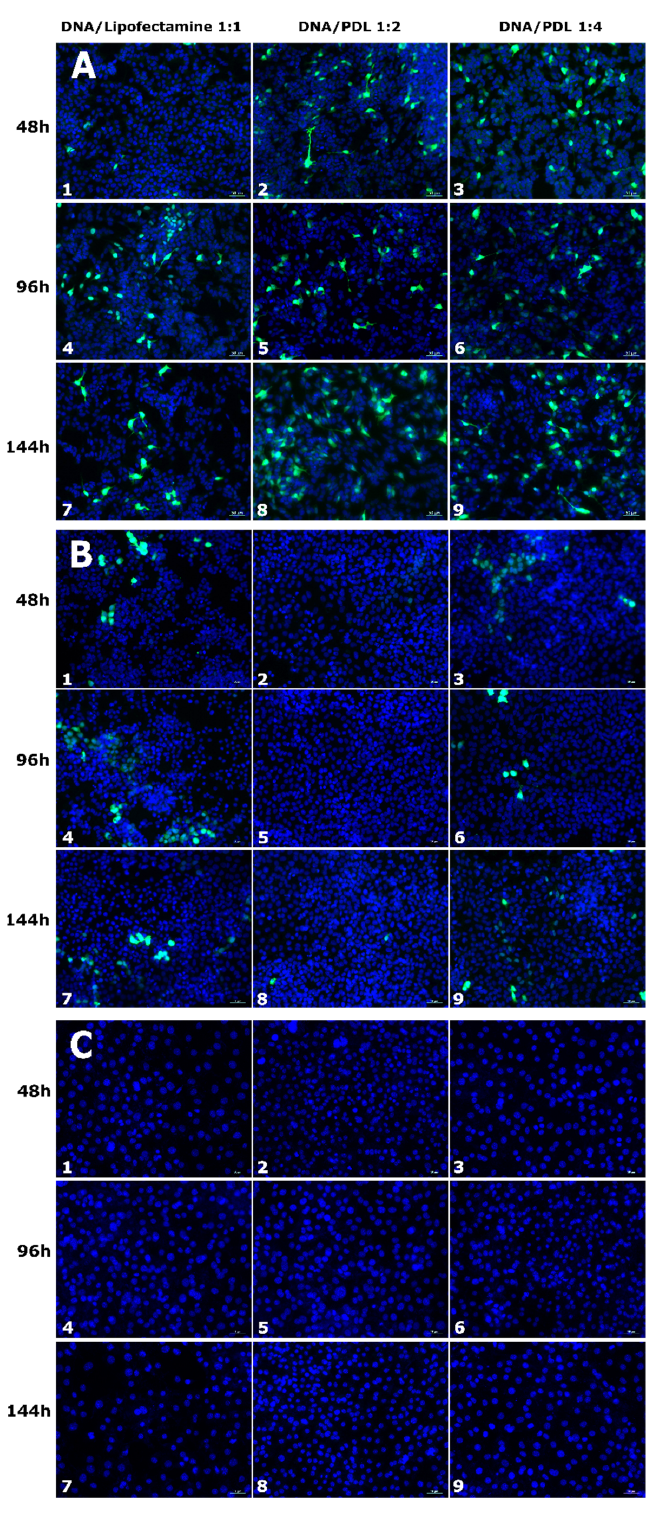
Figure 4. EGFP expression in SH-SY5Y ( A ), HeLa ( B ), and 3T3 ( C ) cells transfected with PDL or lipofectamine. EGFP expression (green) in cells treated with lipofectamine (1, 4, 7 columns), DNA/PDL (1:2) (2, 5, 8 columns) and DNA/PDL (1:4) (3, 6, 9 columns) for 48 h (1, 2, 3 rows), 96 h (4, 5, 6 rows) and 144 h (7, 8, 9 rows) in each cell line. Cell nuclei were stained with Hoechst (blue). Scale = 50 µ